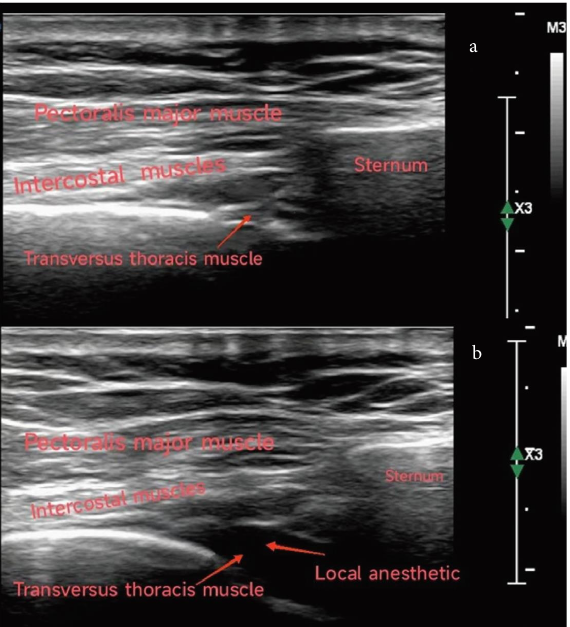
Figure 1: Te ultrasound images in the TTMPB. (a) Ultrasound image before TTMPB; (b) ultrasound image after TTMPB. TTMPB: transversus thoracis muscle plane